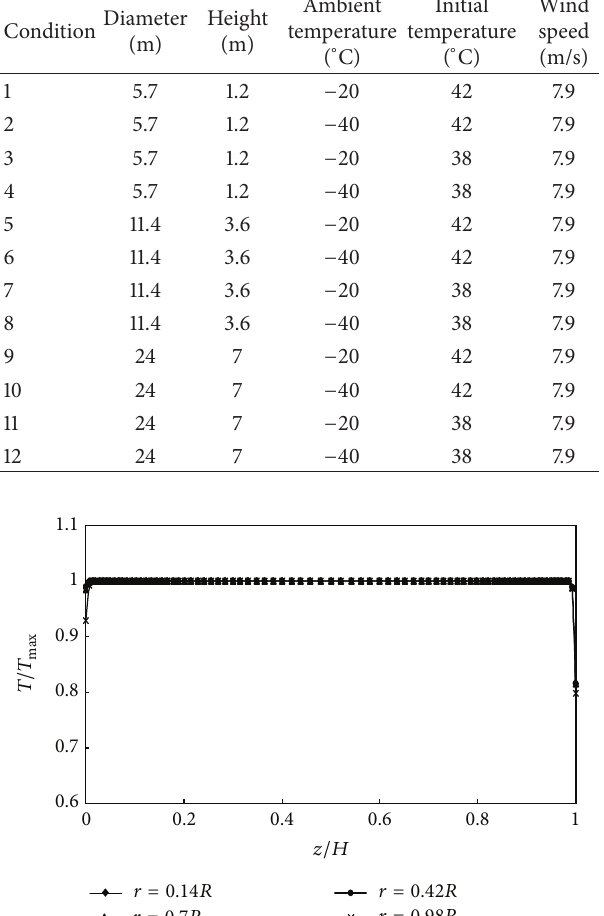
Table 2: Main parameters for different working conditions.